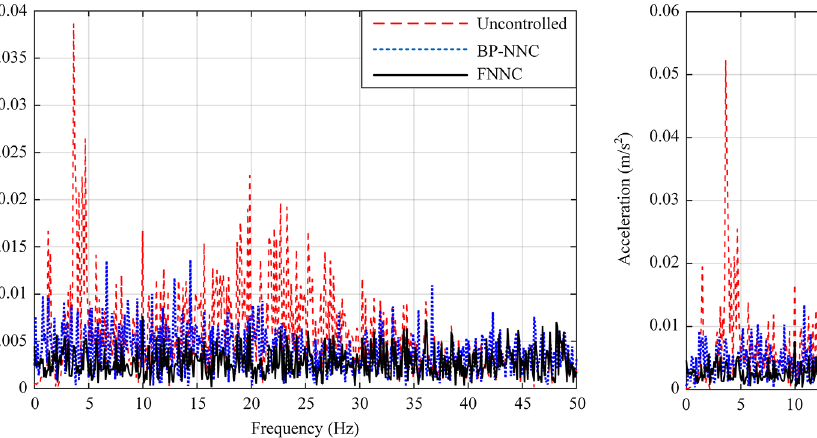
Fig. 28. Frequency-domain response of horizontal vibration acceleration of the elevator car frame with no load.